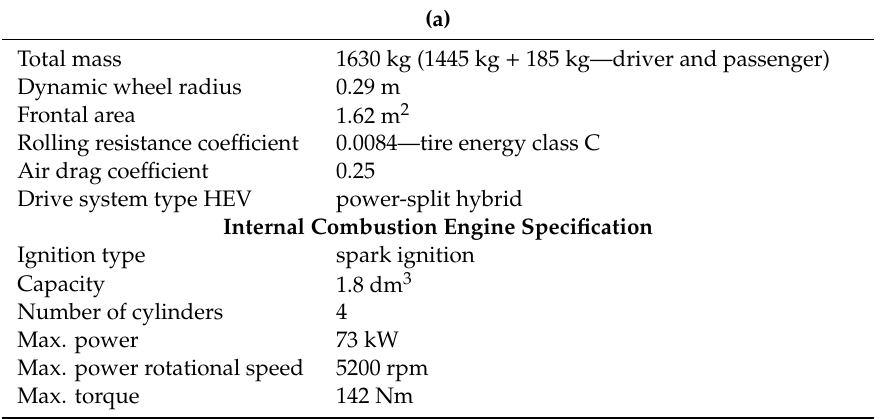
Table 1. (a) Vehicle parameters; (b) Vehicle